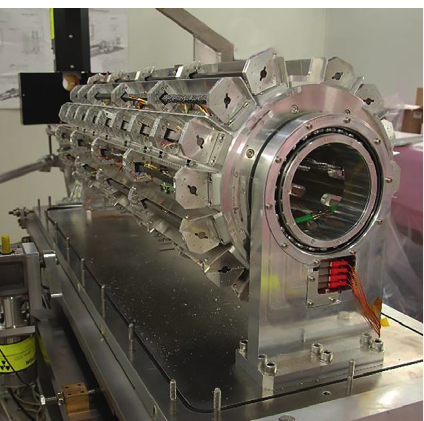
Figure 2: Rotatable barrel and mounted target stations in the HRMT36 experiment